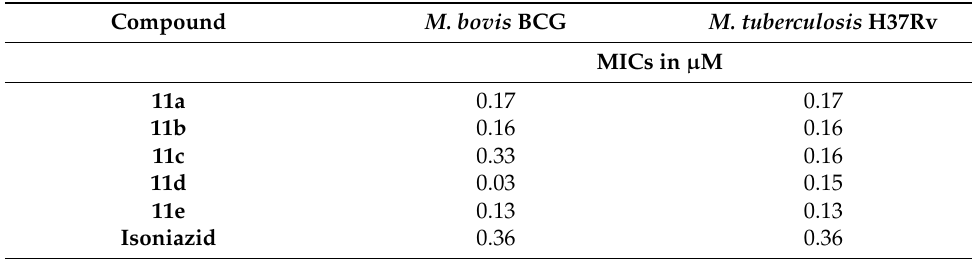
Table 8. Antimycobacterial activity against M. tuberculosis H37Rv and M. bovis.